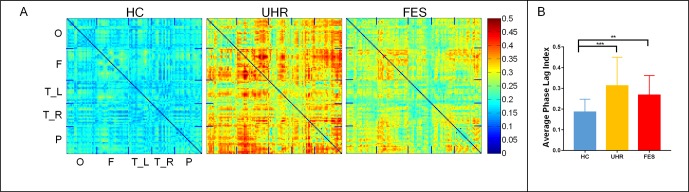
First-episode schizophrenia (FES) and individuals with ultra-high risk for psychosis (UHR) showed an increased spontaneous eyes-closed alpha-band PLI relative to healthy controls (HC). No significant differences were observed for comparisons between the FES and UHR groups. (A) Differences can be seen in the PLI distribution of the three groups. The horizontal and vertical axes were electrodes, and the sequences of the electrodes were occipital network (O), frontal network (F), left (T_L) and right (T_R) temporal network, and parietal network (P). (B) Global PLI (average of 128 × 128 network) ANOVA results. Post hoc t-tests were corrected by Bonferroni. Significantly different results are indicated by asterisks (**: p < 0.01, ***: p < 0.001).